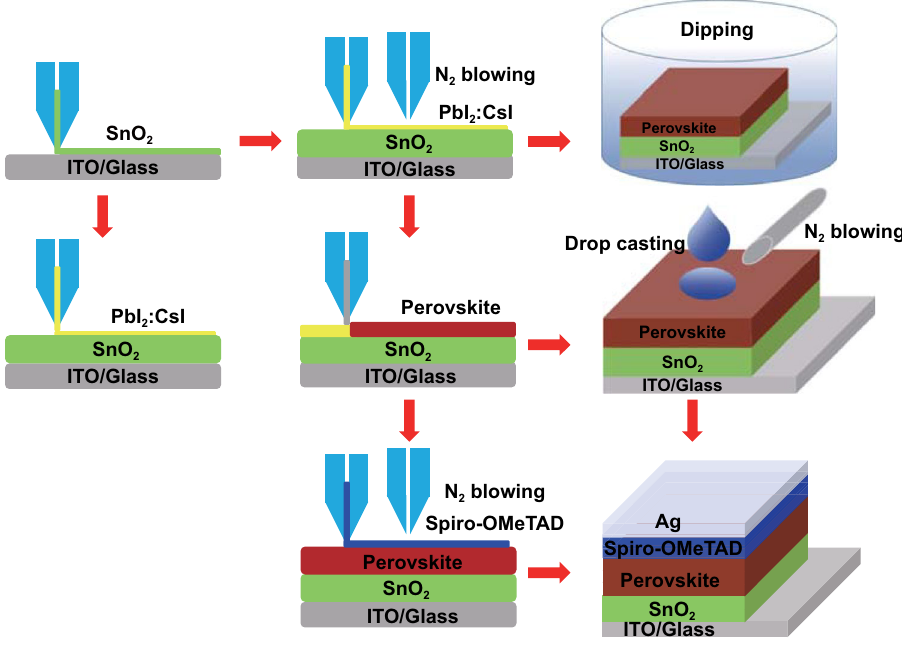
Fig. 1 Schematic of the device fabrication